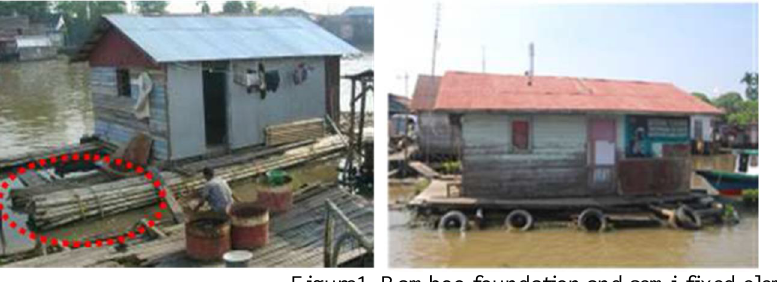
Figure1. Bamboo foundation and semi-fixed element “tire” as protection for foundation still in place Source: Dahliani et al,